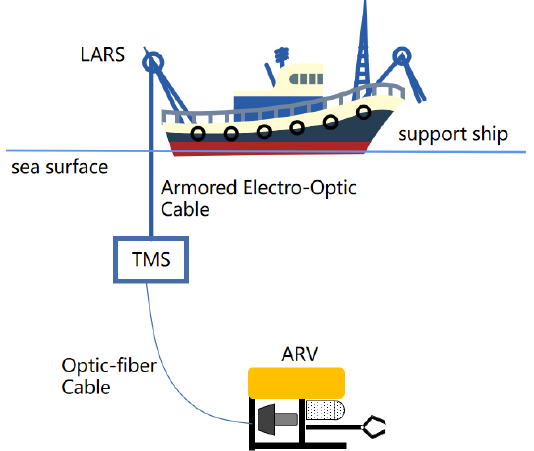
Figure 2. The position relationship of each system during the operation